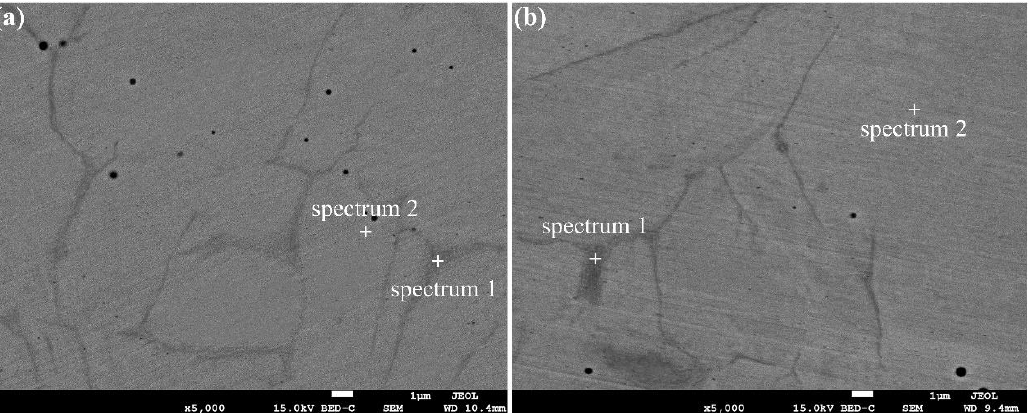
Figure 12. Microstructure of the WM observed by SEM with backscattered electron signal and the locations of the EDS in the ferritic phase (Spectrum 1) and austenitic phase (Spectrum 2): ( a ) without ultrasonic treatment and ( b ) with ultrasonic treatment. Table 3. EDS results of the ferritic phase and austenitic phase marked in Figure 12 (wt.%). Experimental Conditions